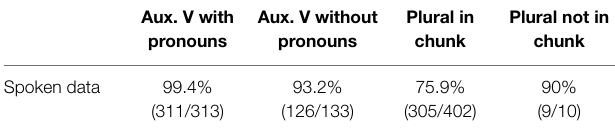
TABLE 10 | Suppliance rates of 3SG auxiliary verbs and regular plurals (±